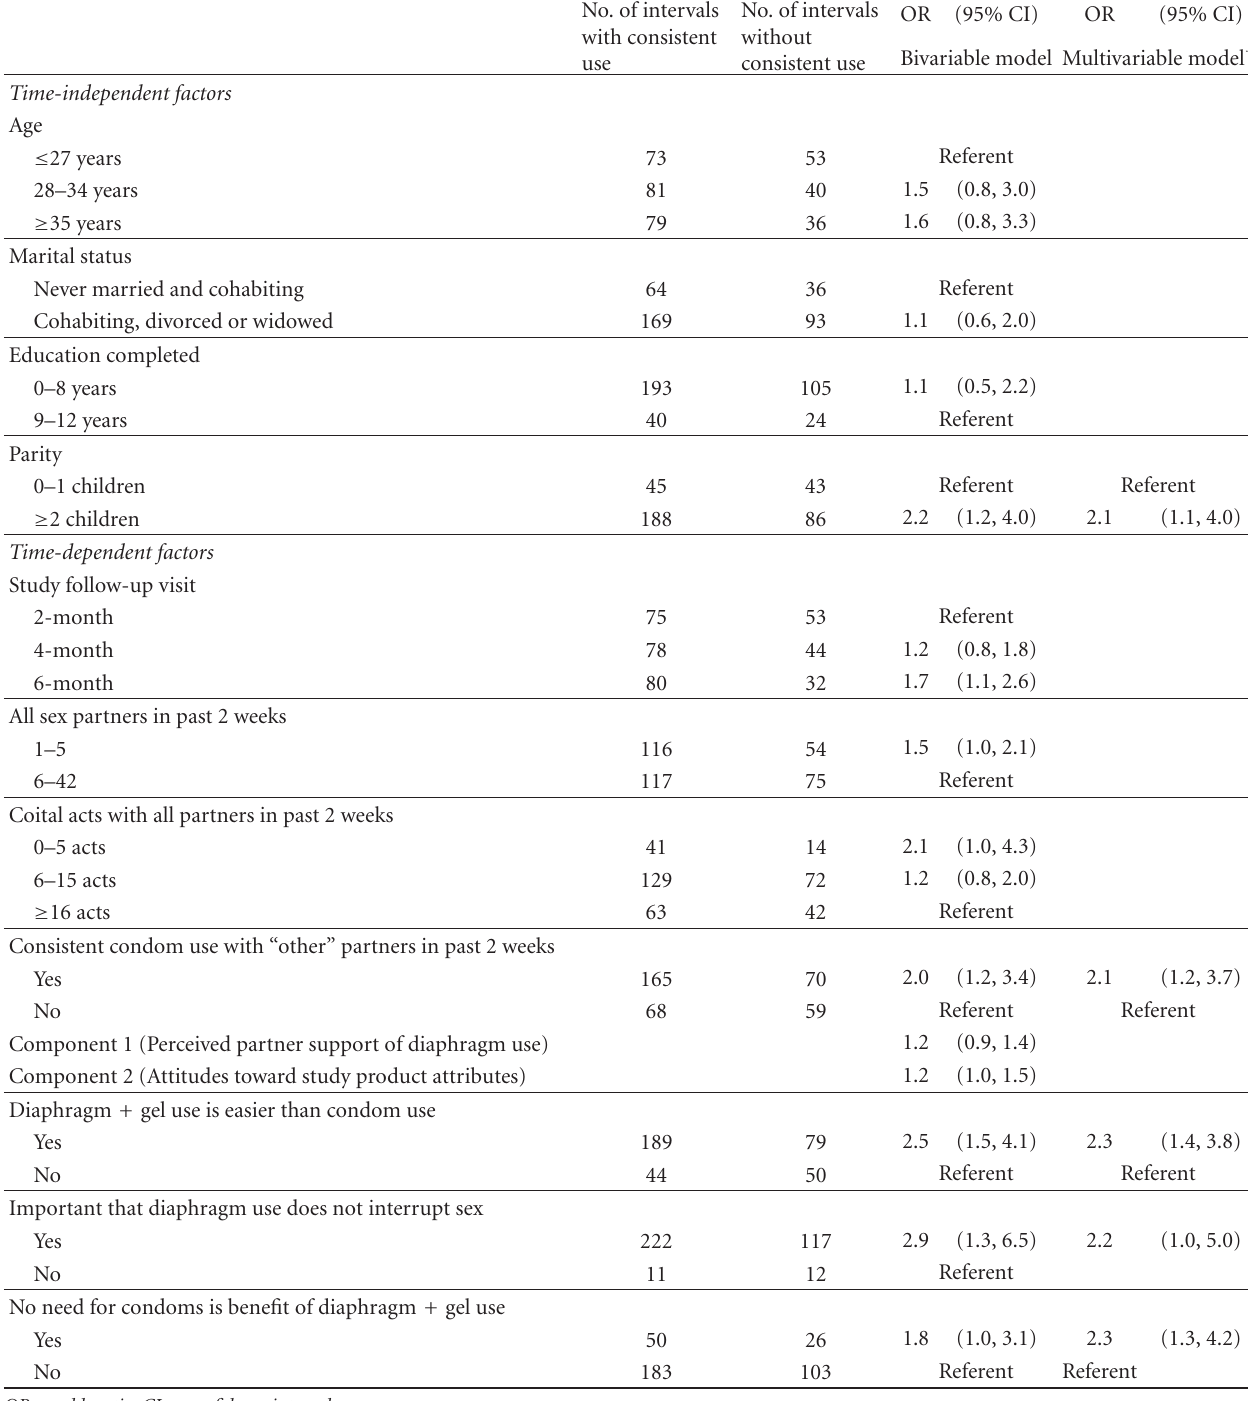
Table 5: Associations between consistent diaphragm use with “other” partners in previous 2 weeks and selected demographic characteristics and attitudes toward diaphragm use, Nairobi, Kenya, 2004-2005 ∗